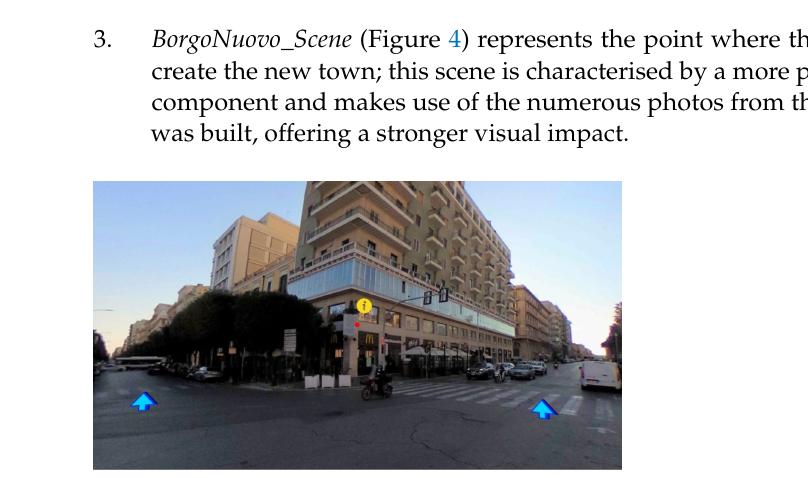
Figure 4. Scene of Borgo Nuovo (the new